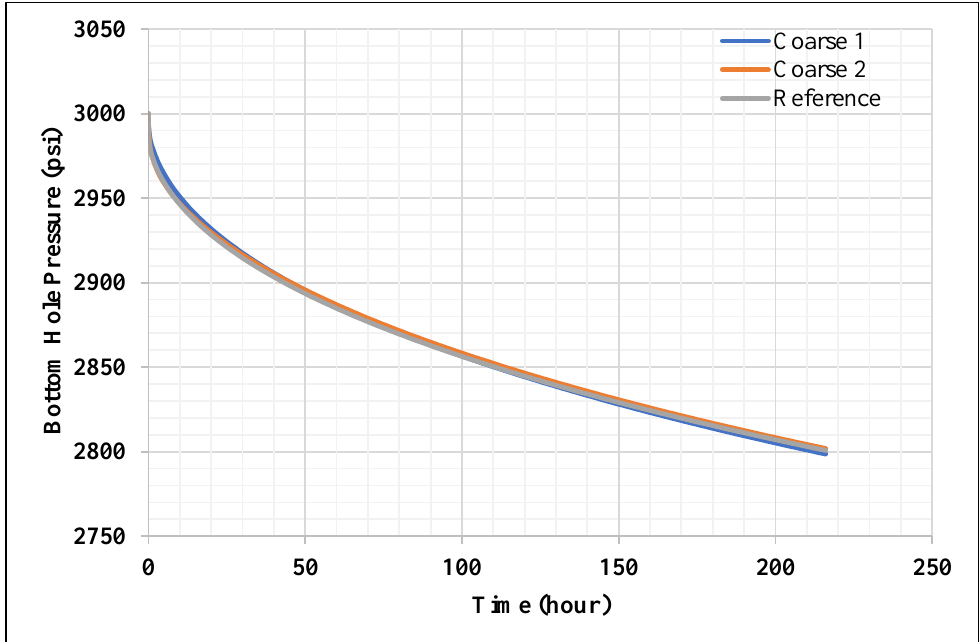
Figure 5. Bottom hole pressure of the Base Case, Coarse Case, and Reference for a constant flow rate.